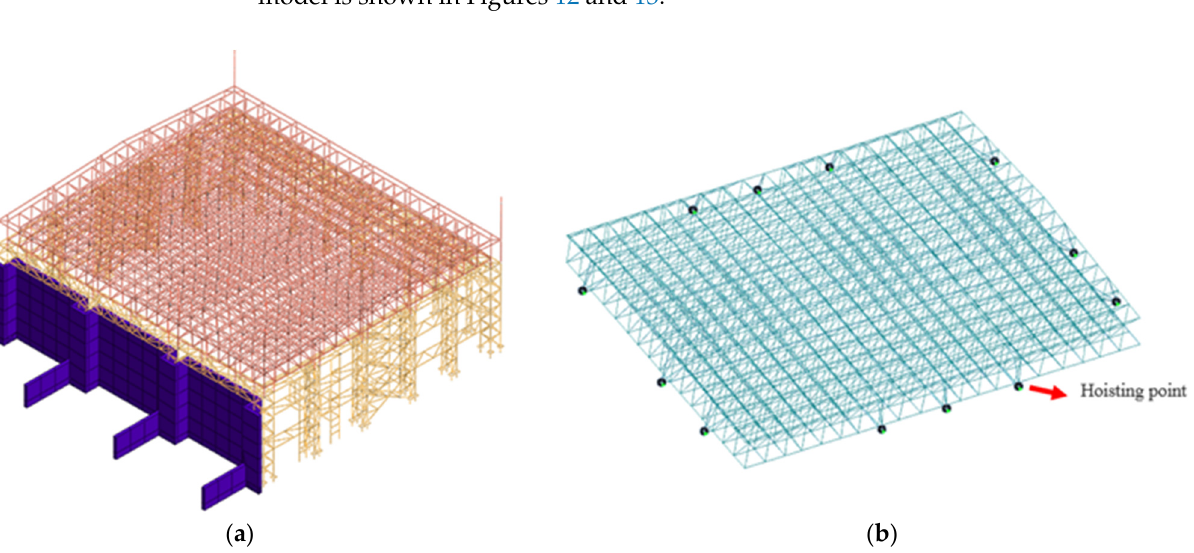
Figure 13. Lifting stage model.